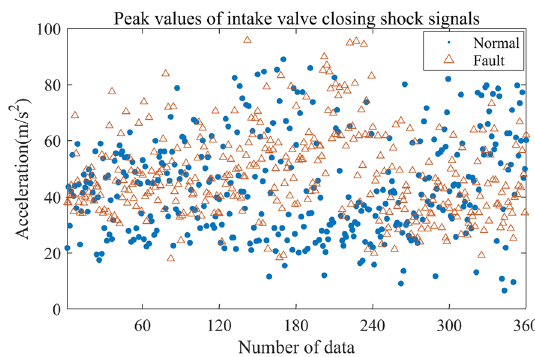
Figure 26 Peak value of intake valve closing shock